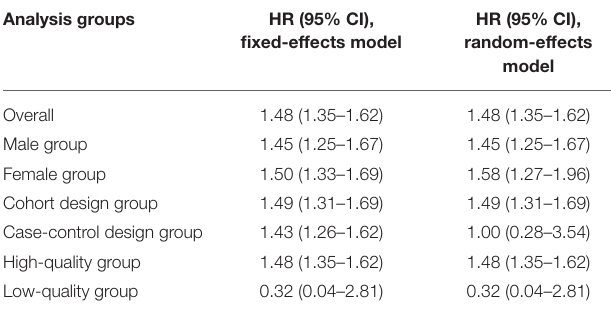
TABLE 4 | Comparison of use of random-effects vs. fixed-effects